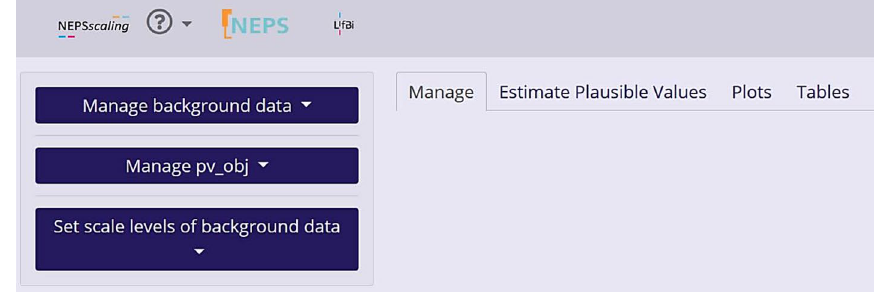
Fig. 1 Start screen of NEPS scaling